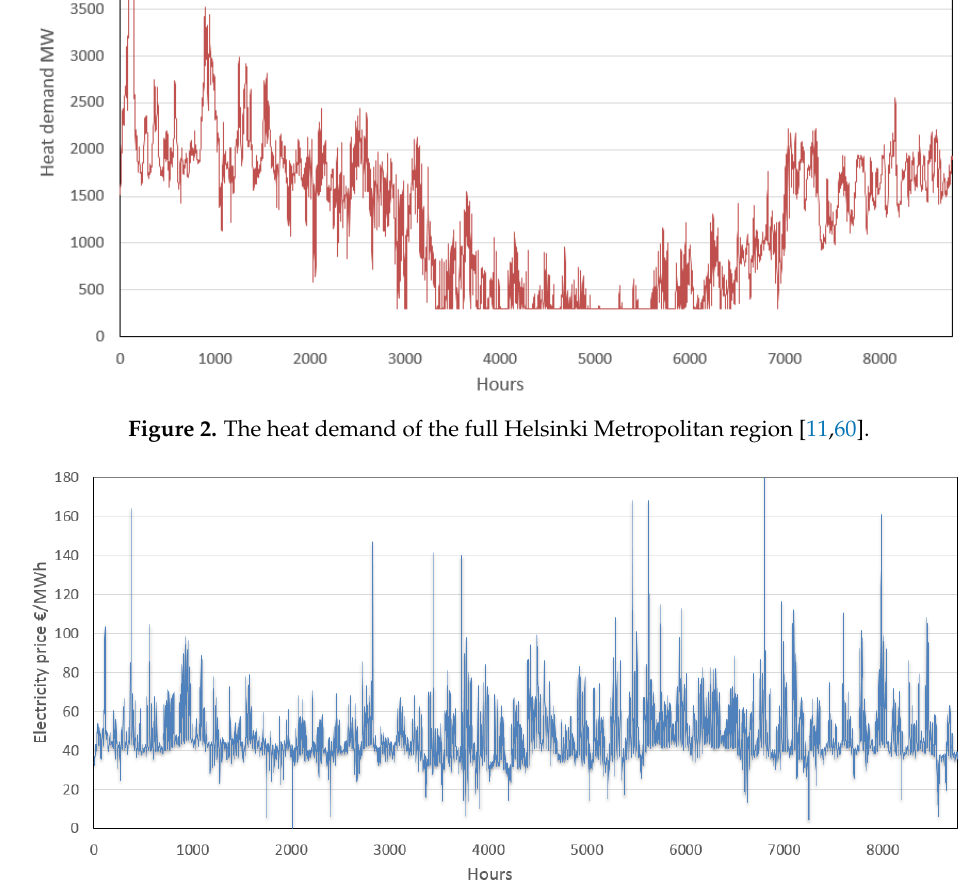
Figure 3. The electricity price series of 2030 used for the scenario